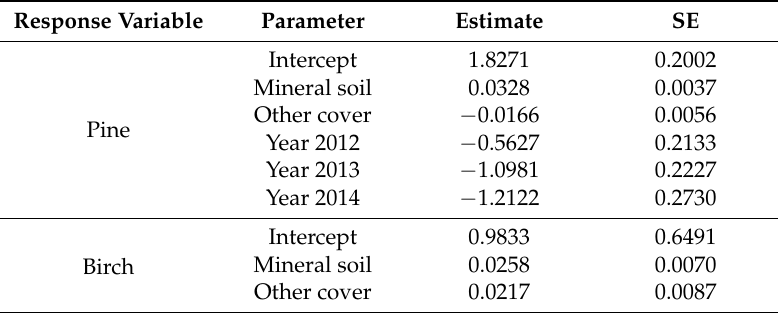
Table 3. Final model parameters with corresponding estimates and standard errors (SE) for Scots pine and birch seedling density fitted as Generalized Linear Mixed Models (GLMMs) with negative binomial error distribution. Stand was included as a random intercept for the pine model, and stand nested within site was included as a random intercept for the birch model. For year, 2011 is the baseline in the models, with parameter estimate set to zero.